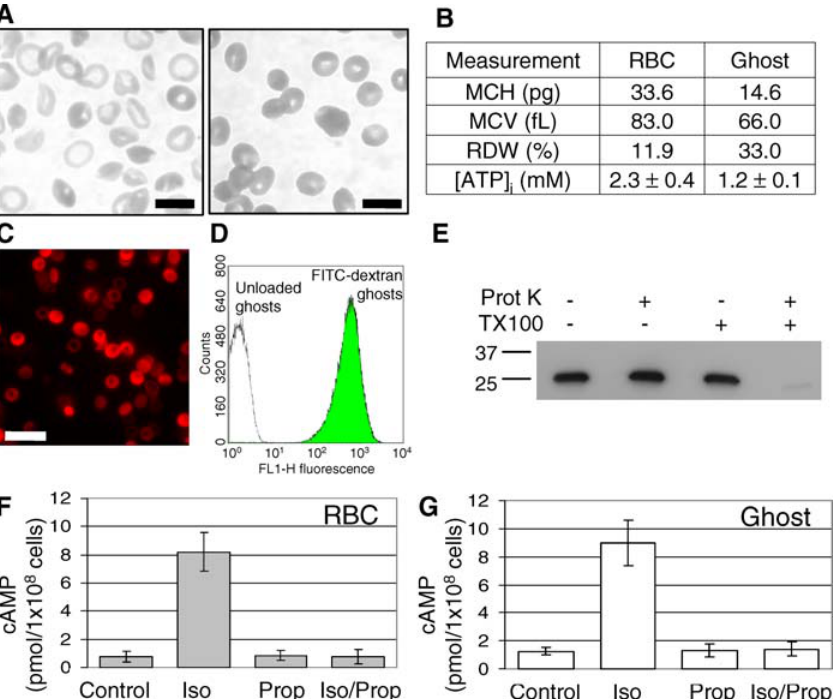
Figure 2. Hematological and Signaling Characteristics and Cargo Loading of Erythrocyte Ghosts (A) Ghosts (left) were biconcave but retained less pigment than intact erythrocytes (right); bar represents 10 l m. (B) Ghost MCH (normal range for erythrocytes 27.5–33.5 pg/cell), MCV (normal range for erythrocytes 80–100 fl), and RDW (normal range for erythrocytes 11.0%–15.0%) were determined using a Coulter counter (see Methods). Intracellular ATP levels were determined by luciferase-based ATP assays (see Methods); the 95% confidence interval (CI) for ATP levels is indicated; two experiments. (C) Ghosts loaded with high molecular weight rhodamine-labeled antibody were imaged without fixation by fluorescence microscopy; bar represents 25 l m. (D) Flow cytometry of unloaded (white fill) and FITC-dextran–loaded ghosts (green fill) 2 h post-resealing, showed homogenous loading of cargo. For each cell type, 100,000 gated events were captured. (E) Western blot of GST-loaded ghosts after incubation in culture for 24 h and subsequent treatment in the presence or absence of proteinase K (Prot K) and/or Triton X-100 (TX100); see Methods. GST was detected by GST-specific immunoblotting. (F) cAMP production in normal, intact erythrocytes treated with isopreterenol (iso) and/or propranolol (prop) as measured by enzyme-linked immunosorbent assay (see Methods ) . Error bars show 95% CI of triplicate measurements in a representative experiment. The mean baseline cAMP concentration in control erythrocytes was 0.61 pmol cAMP (95% CI 0.20–1.01 pmol; three experiments) per 1 3 10 8 cells. Induced cAMP levels can vary—the maximal value obtained (once) was 14.58 pmol cAMP (95% CI 13.11–16.03 pmol) per 1 3 10 8 cells. (G) cAMP production in ghosts measured and depicted as described in (F). Error bars show 95% CI of triplicate measurements in a representative experiment. The mean baseline cAMP concentration in control ghosts was 1.12 pmol cAMP (95% CI 0.59–1.64 pmol; three experiments) per 1 3 10